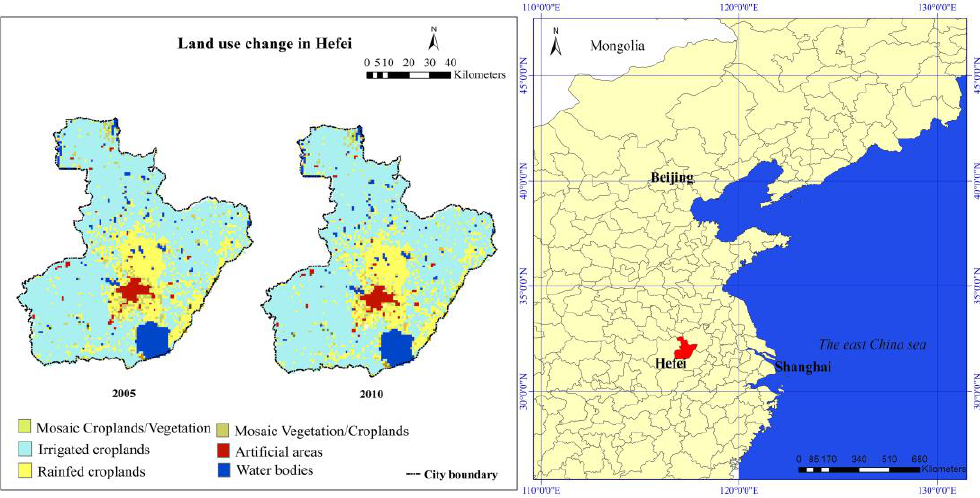
Figure 1 . Land use in Hefei city in 2005 and 2010. Figure 1. Land use in Hefei city in 2005 and